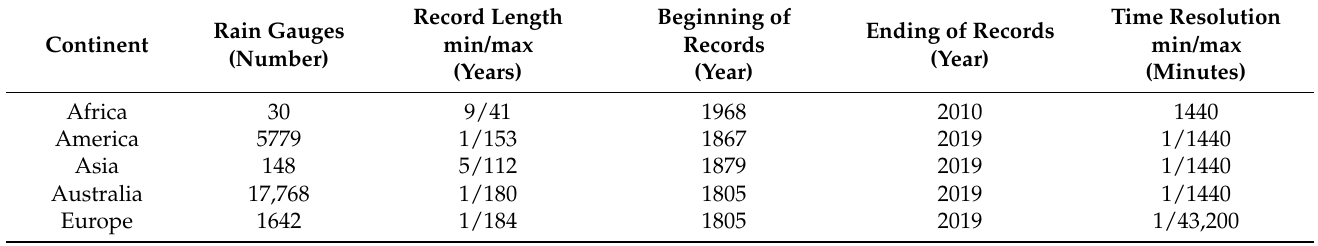
Table 1. Main characteristics of the available rainfall recordings for the rain gauge stations included in the database set up by Reference [35] grouped by continent.